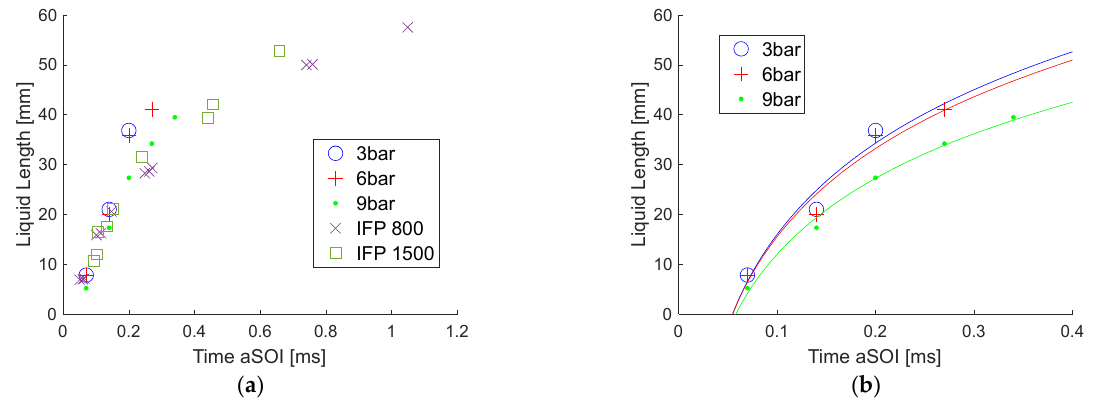
Figure 8. Spray tip penetration: ( a ) as a function of time, at 3, 6 and 9 bar ambient pressure, compared to data from [16]; ( b ) as a function of time, at 3, 6 and 9 bar ambient pressure and natural logarithmic model fit.